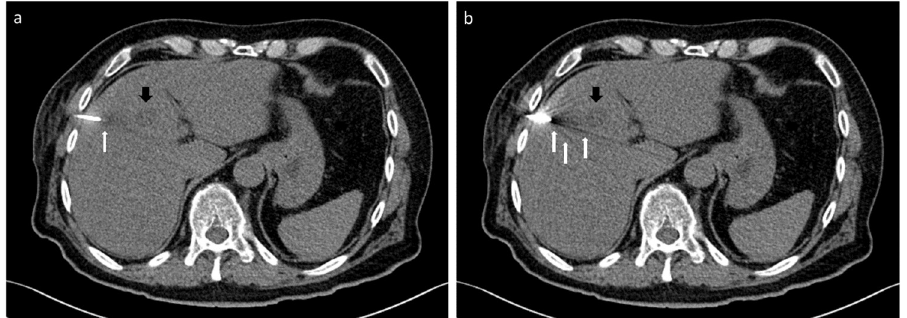
Fig 8. Images of a patient during CT-guided biopsy of a liver metastasis of a chordoma (black arrow) in SE technique displaying less streak artifacts at the crucial part of liver parenchyma bordering to the trocar (white arrow) on images with iMAR (a) than without iMAR